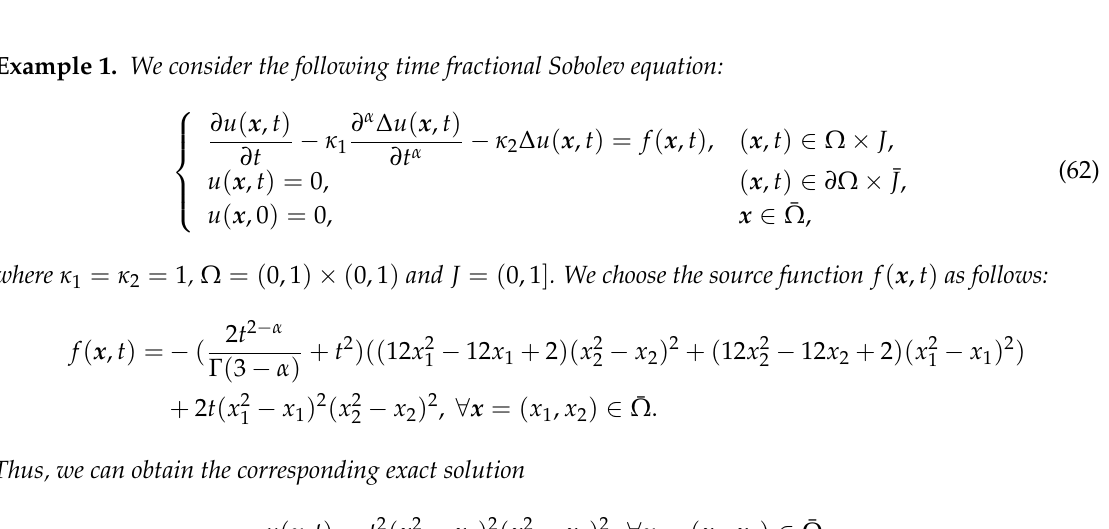
√ 2 for Example 1. 160